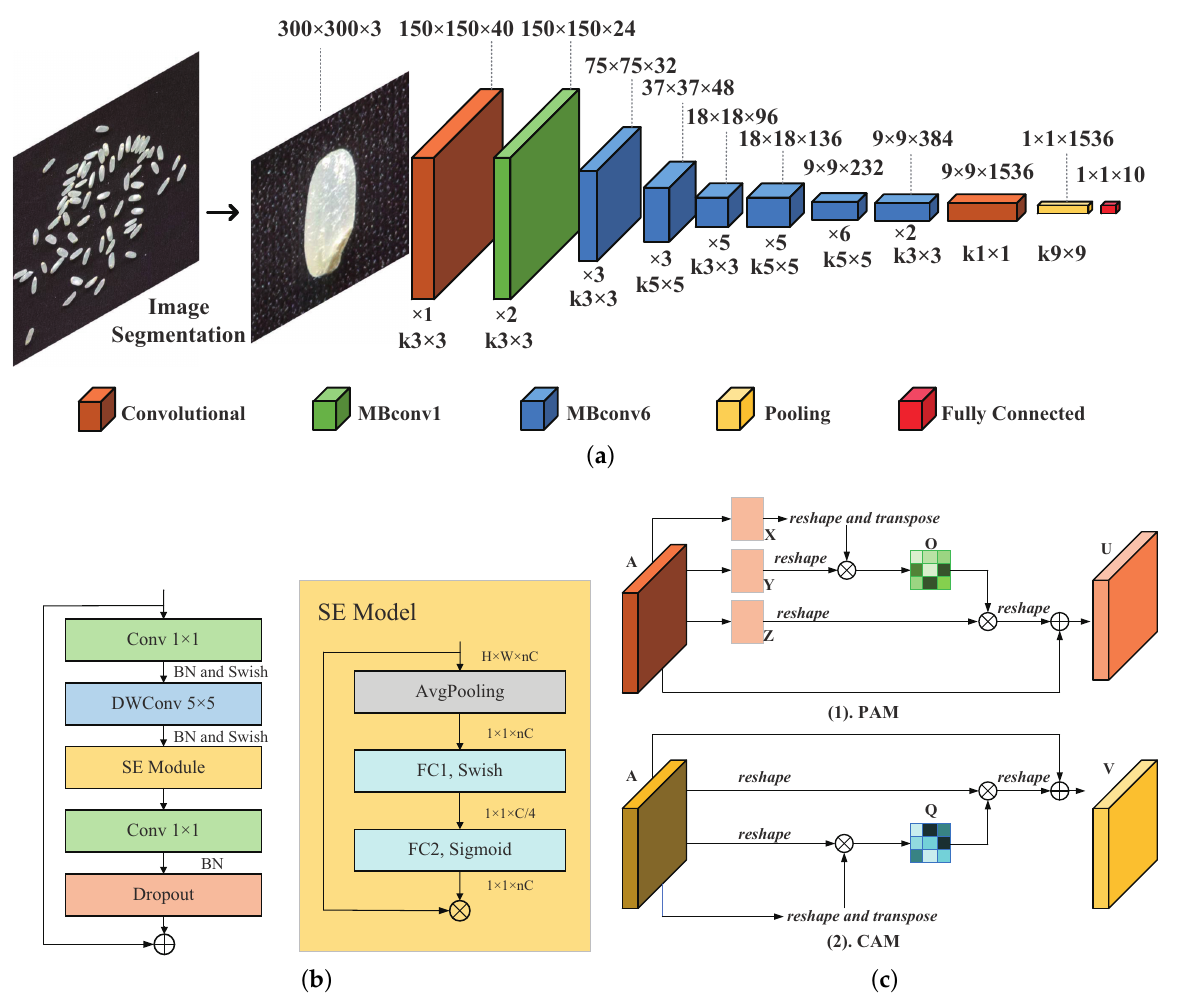
Figure 7. The individual structures included in EfficientNet–B3–DAN. ( a ) The structure of the EfficientNet–B3. × n indicates that the layer is repeated n times, and kn × n indicates that the size of the convolution kernel is n . MBConv means mobile inverted bottleneck convolution, proposed by Sandler et al. [37]. The image input size is 300 × 300, and the final classification result is output through the convolutional layer, the MBconv1 layer, the MBConv6 layer, the pooling layer, and the fully connected layer. ( b ) On the left the is structure of the MBConv. Conv represents the convolutional layer, BN represents the batch normalization layer, Swish means the Swish activation function, DWConv means the deep separable convolution, and SE represents the squeeze-and- excitation [38]. The size of the input feature map is H × W × C, and the dimension is expanded by n times through the 1 × 1 convolutional layer. For example, Mbconv6 means to expand by six times. On the right is the structure of SE. AvgPooling denotes average pooling and FC denotes fully connected layer. Through this module, the dependencies between different channels can be adaptively learned. ( c ) The structure of DAN. The upper figure represents the PAM. Input feature map A, the size is C × H × W, and the feature map A is convolved to obtain X, Y, Z, and the size is still C × H × W. Transform X and Y into X (cid:48) , Y (cid:48) , their size is C × M, where M = H × W. After that, X (cid:48) · ( Y (cid:48) ) T is calculated. Compute the O by softmax with size ( H × W ) × ( H × W ) . Transform the size of Z to C × M, multiply it with O, and finally sum with A to obtain the final output U. The lower figure represents the CAM. The input feature map is still A, transform A into A (cid:48) , the size is C × M. A (cid:48) · ( A (cid:48) ) T is calculated. Q is output through the softmax layer, the magnitude of Q is C × C. Multiply Q and A (cid:48) , and the result size is transformed into C × H × W. Finally, add A to obtain V. The PAM is summed with the CAM as the output of the dual attention